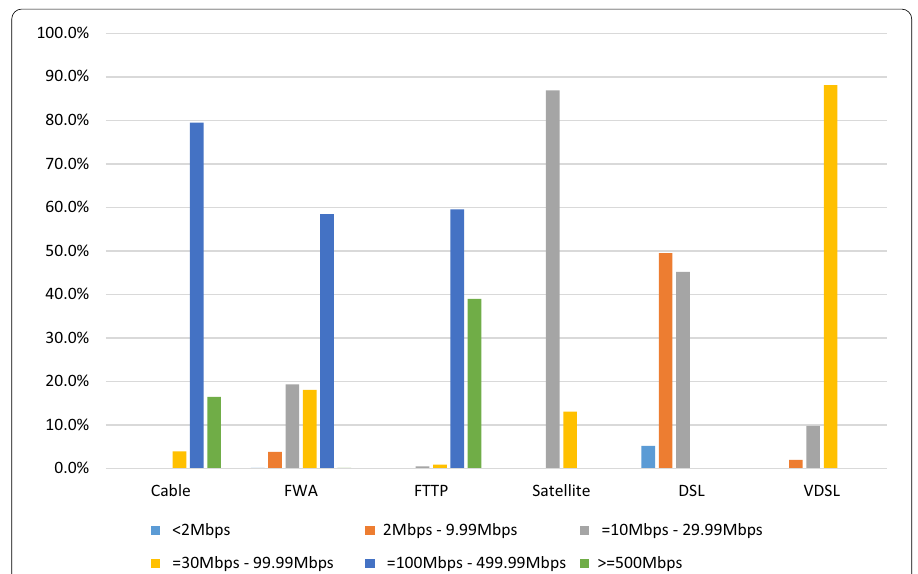
Fig. 1 Advertised broadband download speeds by fixed platform, Q3 2020. FWA fixed wireless access, FTTP fibre to the premises, DSL digital subscriber line, VDSL very-high-bit-rate digital subscriber line. Source